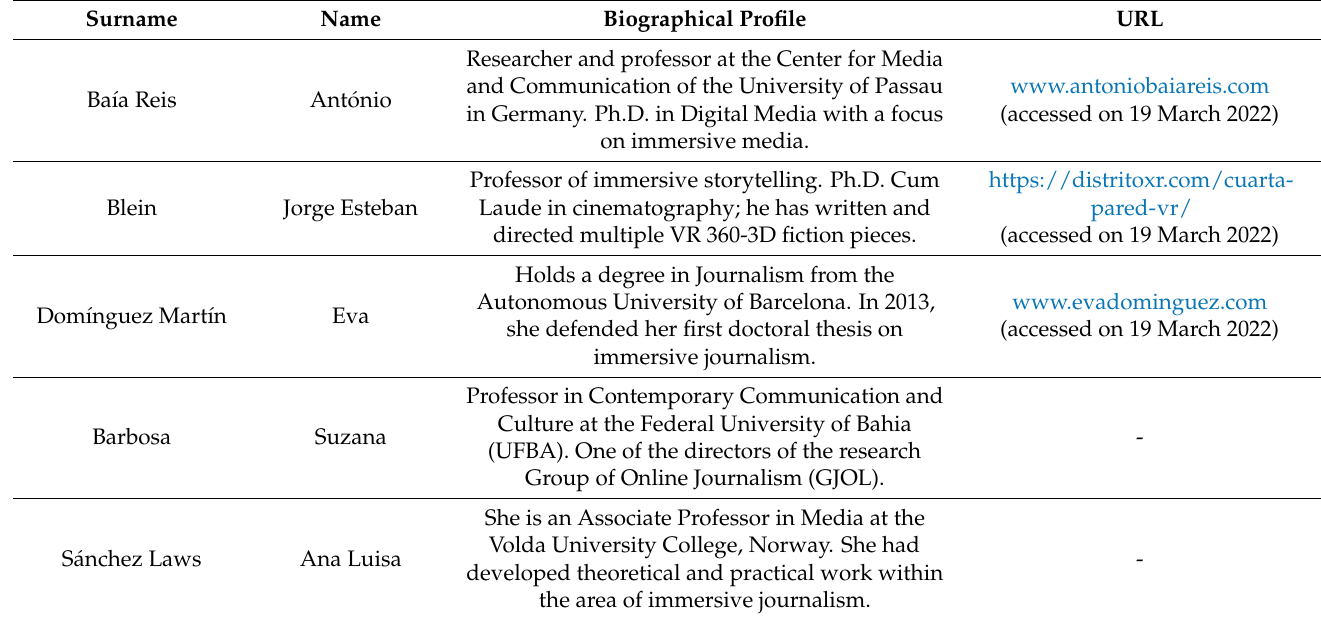
Table 2. List of participants in the academics’ focus